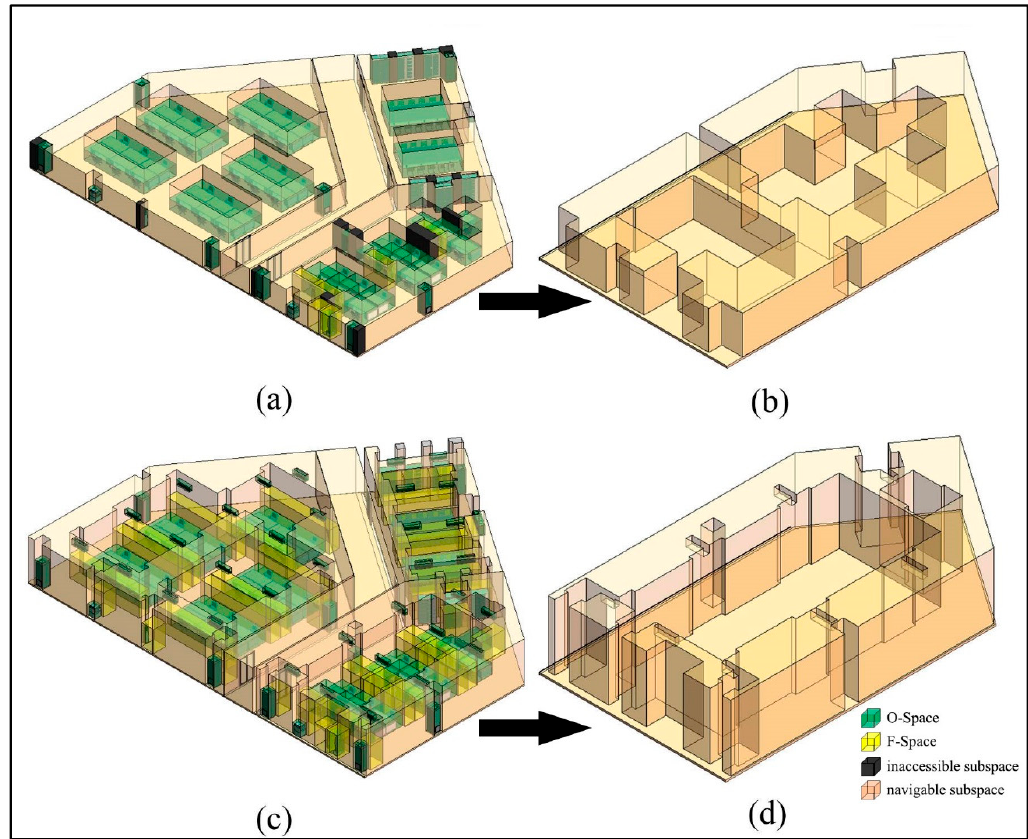
Figure 14. The differences between the generation of the navigable space between the proposed method in this paper and the flexible space subdivision (FSS) framework. ( a ) Inaccessible subspaces and CN-Space generated by the proposed method. ( b ) Partial detail presentation of CN-Space. ( c ) The navigable space generated by the FSS framework. ( d ) Partial detail presentation of the navigable space generated by the FSS framework.